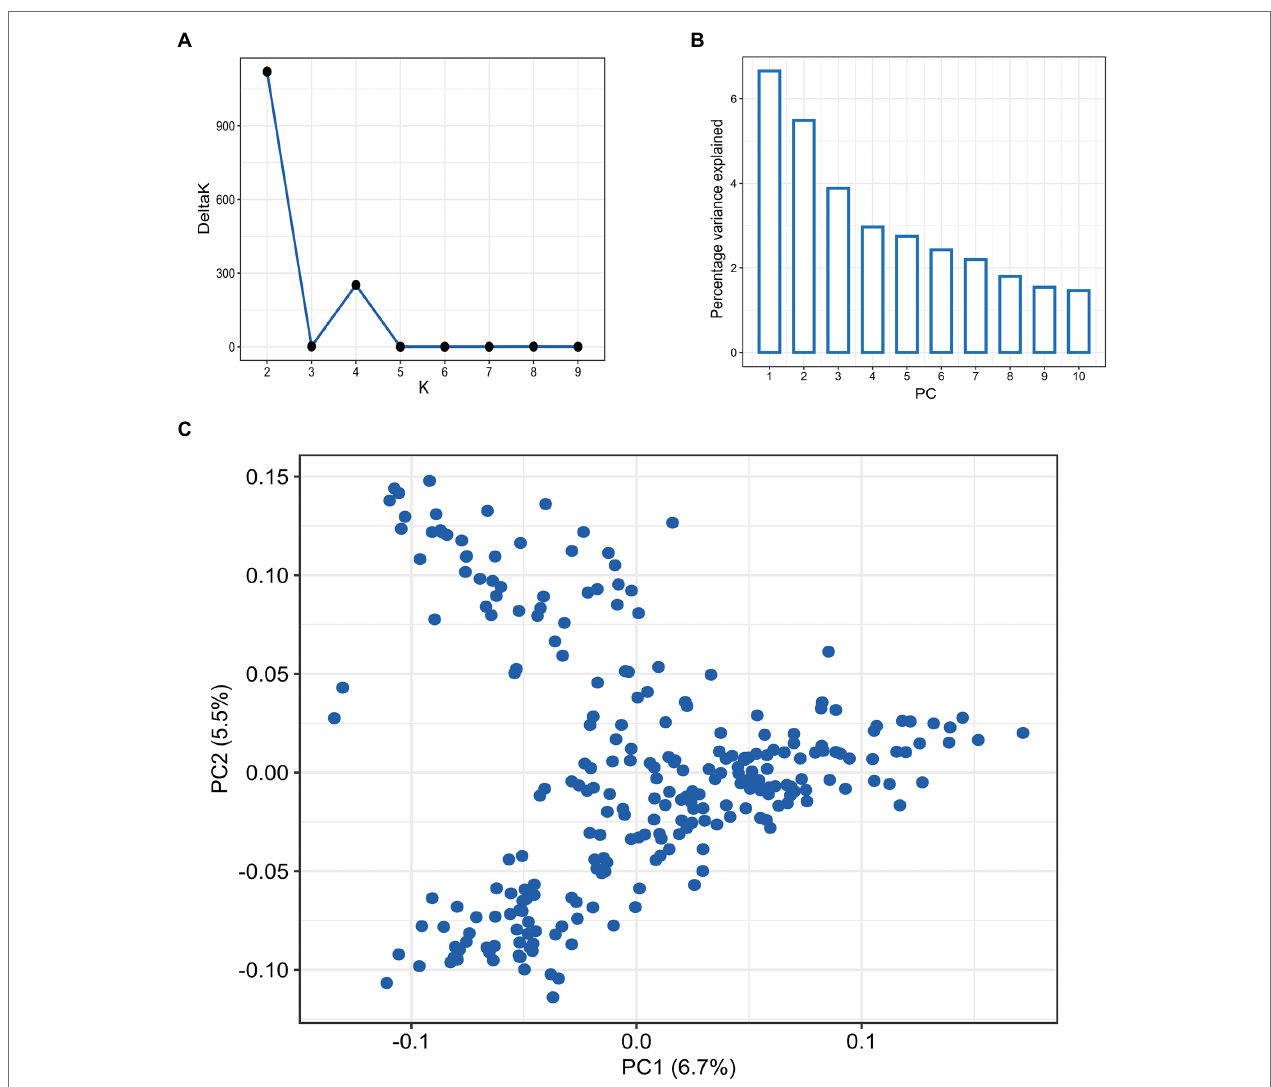
FIGURE 2 | Population structure analysis in hard winter wheat breeding panel of 257 lines based on the 9,321 SNPs, (A) Evanno plot of Delta-K statistic from the STRUCTURE analysis. (B) Scree plot for first 10 components obtained from principal component analysis (PCA). (C) Scatterplot for the first two components (PC1 and PC2) from